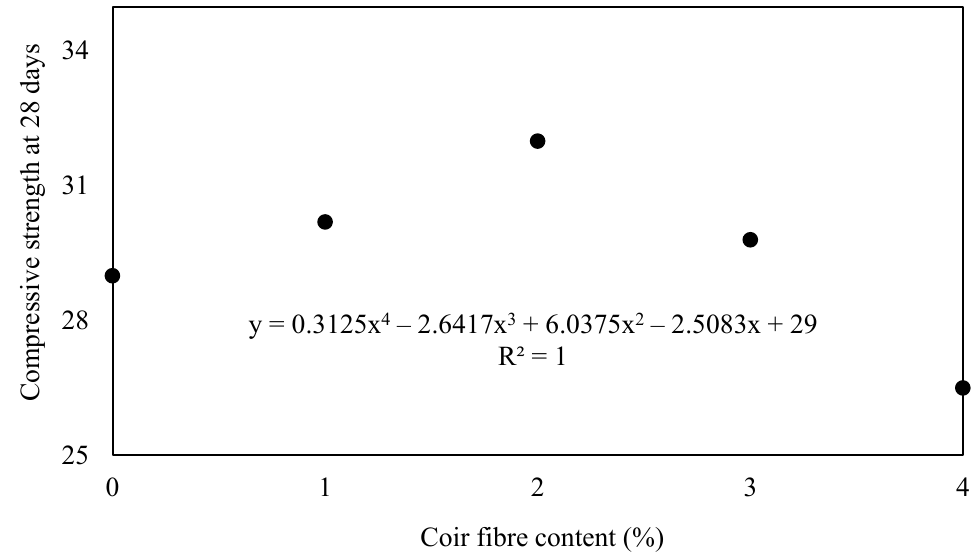
Figure 5. Relationship between coir fiber content and compressive strength, estimation equation of compressive strength at 28 days, and r square value for concrete containing coir fiber.